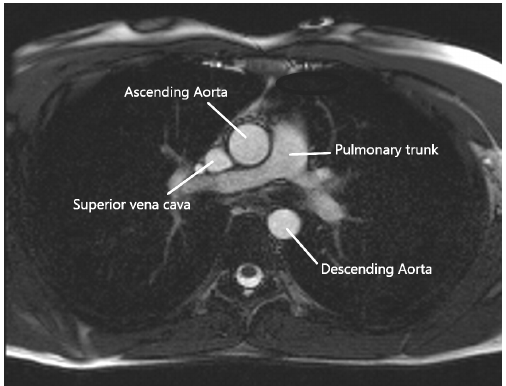
Figure 1. Axial MRI at the level of the pulmonary trunk.